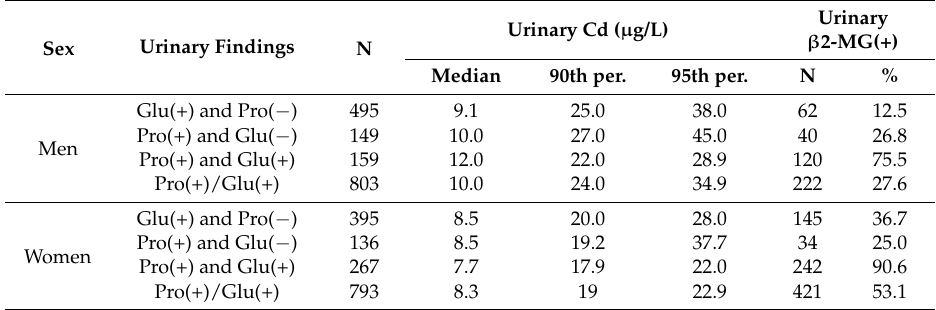
Table 2. Median and 90th and 95th percentiles of urinary Cd and positive rate (%) of urinary β 2-microglobuline ( ≥ 1 mg/dL) in groups with different urinary